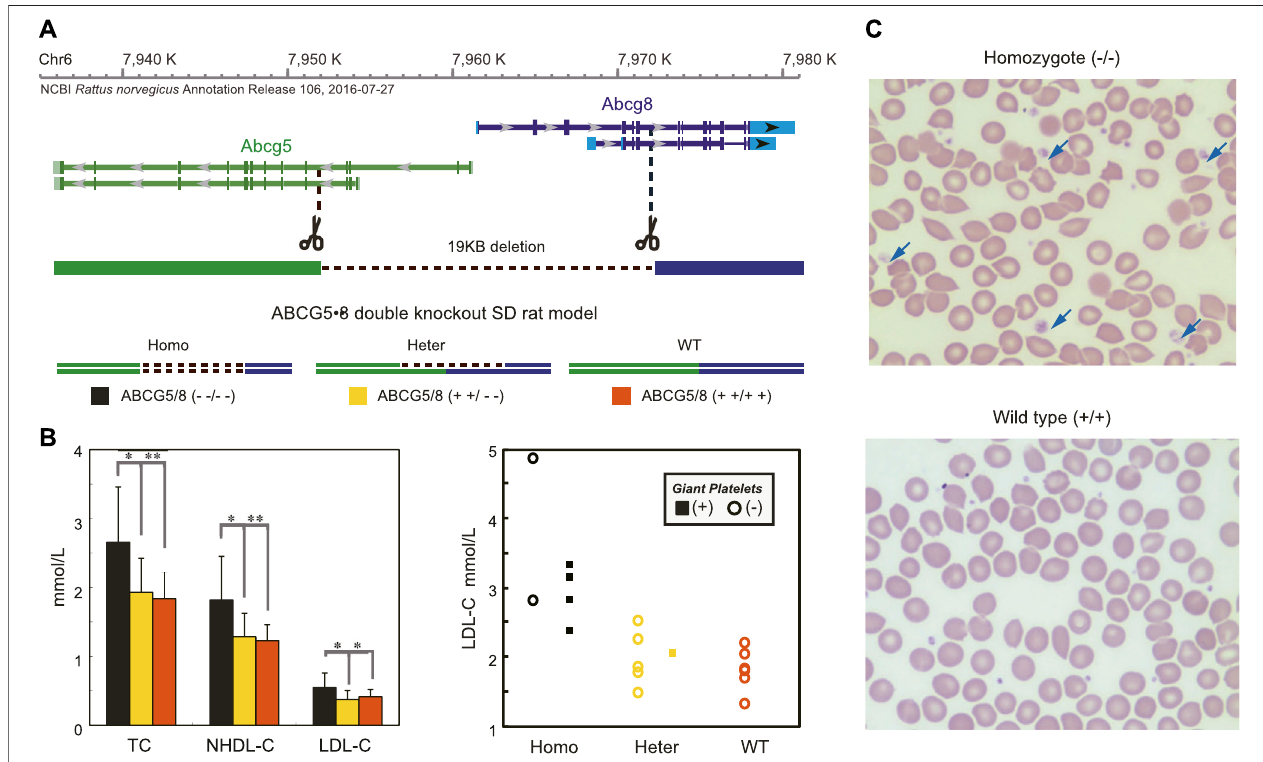
FIGURE 3 | Disruptions of ABCG5/8 Genes Mimicked the Phenotypes of the Proband in the Double Knockout Rats. Panel (A) shows the strategy for the generationof ABCG5/8 doubleknockoutusingtheCAS9/sgRNAsystem.Panel (B) showedsigni fi cantlyincreasedbloodlipidlevels (left) andthelargeplatelet (right) in thehomozygotescomparedwithtwoothergroups.Foreachgroup,thebloodlipidlevelsandthelargeplateletweredeterminedfromrandomlyselectingrats.Thevalues of the blood lipid levels are expressed as the mean ± SE. n (cid:2) 6. * p < 0.05, ** p < 0.01. The large platelet was detected in over 80% of homozygotes, and none was found in the wild-type strain. Panel (C) shows a blood smear for three groups of the rat